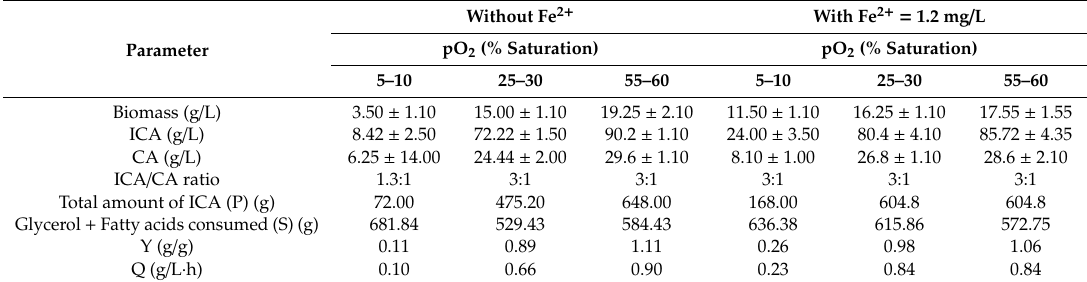
Table 6. E ff ect of aeration on growth and ICA production by Y. lipolytica VKM Y-2373.